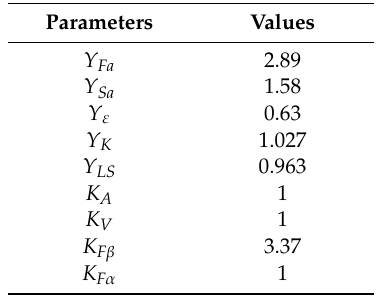
Table 3. Major parameters for calculating the tooth root bending stress.